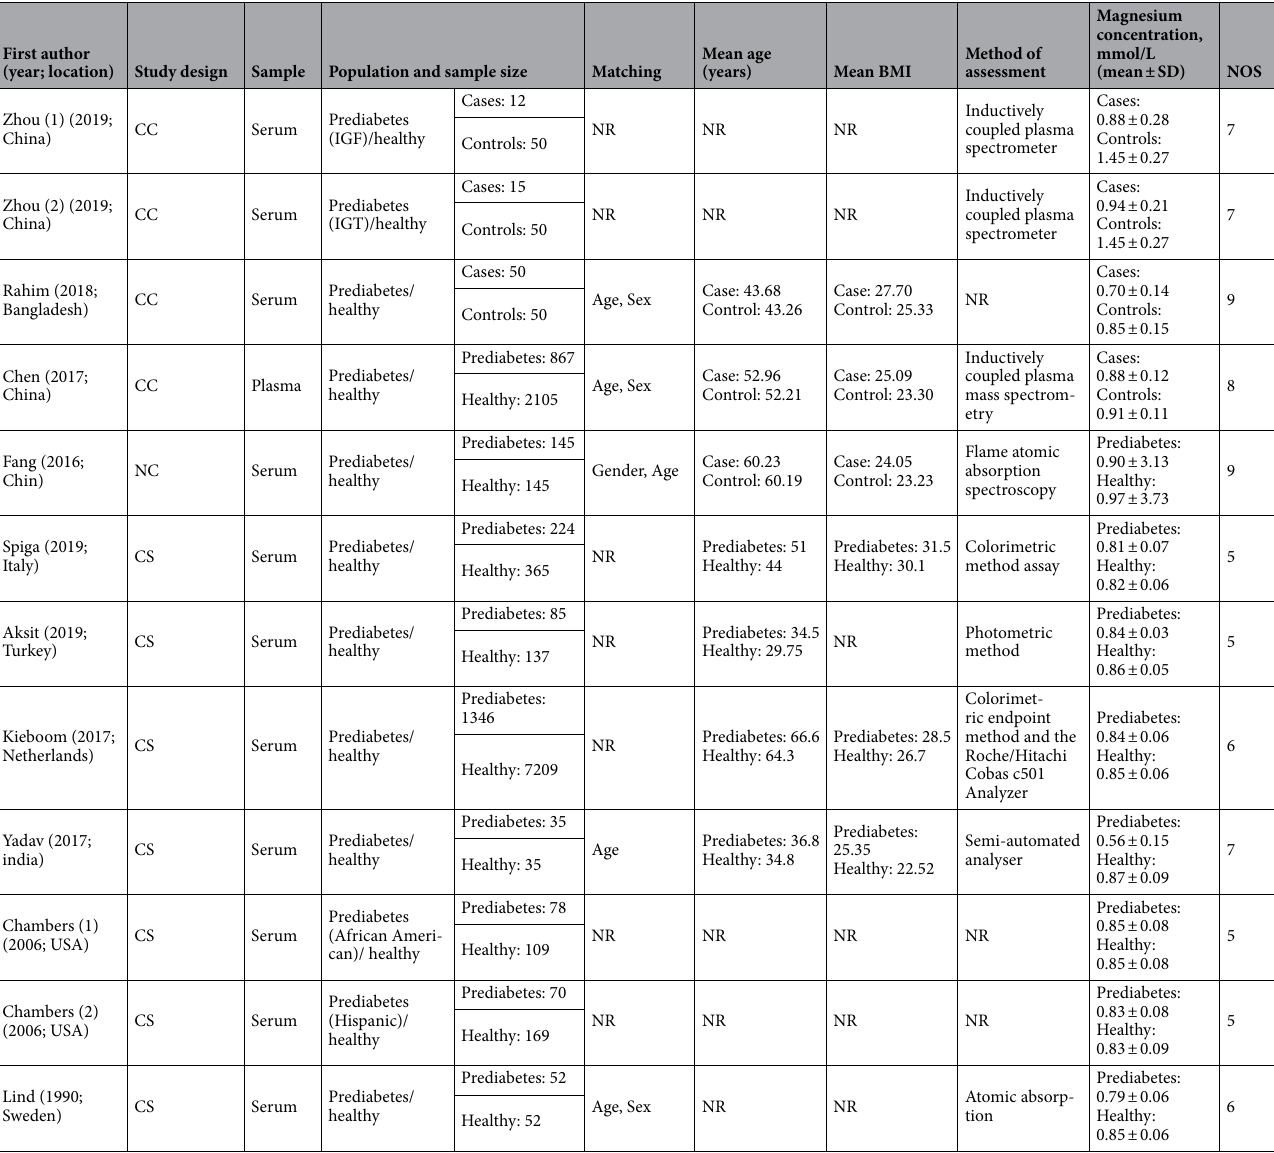
Table 1. Characteristics of included studies. BMI Body Mass Index, CC Case–Control, CS cross sectional, NC Nested case–control, Mg Magnesium, ADA American Diabetes Association, WHO World Health Organization, NR Not